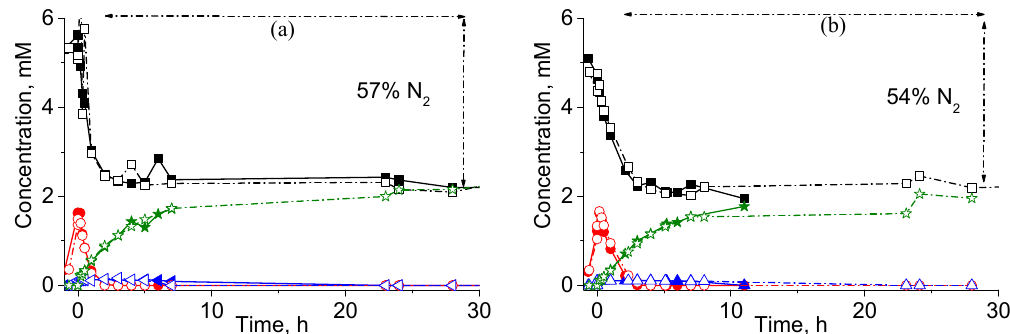
Figure 2. Evolution of: ( a ) Total Organic Carbon (TOC) and ( b ) concentrations of Total Nitrogen (TN) Figure 9. Transformation of organic nitrogen in the sugarcane e ffl uent in the presence of ( a ) Pt / TiO 2 (measured by TOC-TN apparatus) and different N-species (analyzed by ionic chromatography) Figure 9. Transformation of organic nitrogen in the sugarcane effluent in the presence of ( a ) Pt/TiO 2 and ( b ) Pt / ZrO 2 . TN ( (cid:4) ), NH 4 + ( (cid:8) ), NO 3 − ( during oxidation of diluted VBC in the absence of a catalyst: TN ( ■ ), NH 4+ ( • ), NO 3- (  ), and NO 2- ( 7 ). and ( b ) Pt/ZrO 2 . TN ( ■ ), NH 4+ ( • ), NO 3- (  ) NO 2- ( ▲ ). Empty symbols show the results of duplicate experiments. At time zero, after introduction of air at the reaction temperature, TOC concentration was, as expected, around 1500 mg L –1 (Figure 2a). Some organic compounds in VBC were then mineralized to attain 60% TOC conversion after 7 h at 190 °C. Table 3. Pt loss from the catalyst; concentrations of N-species during the reaction over 2.36% Pt/ZrO 2 .